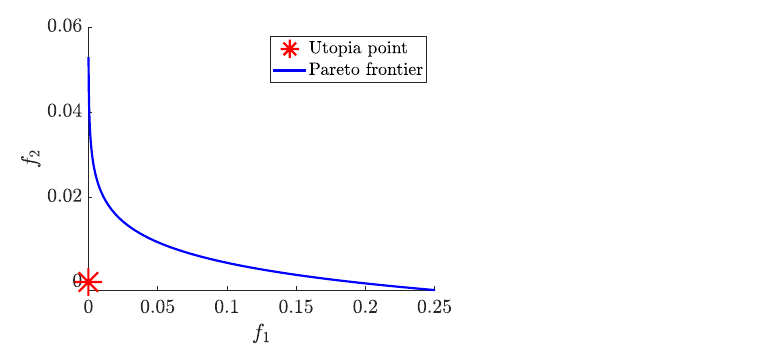
Figure 17. Compromise optimization in the Pareto frontier for the Van de Vusse